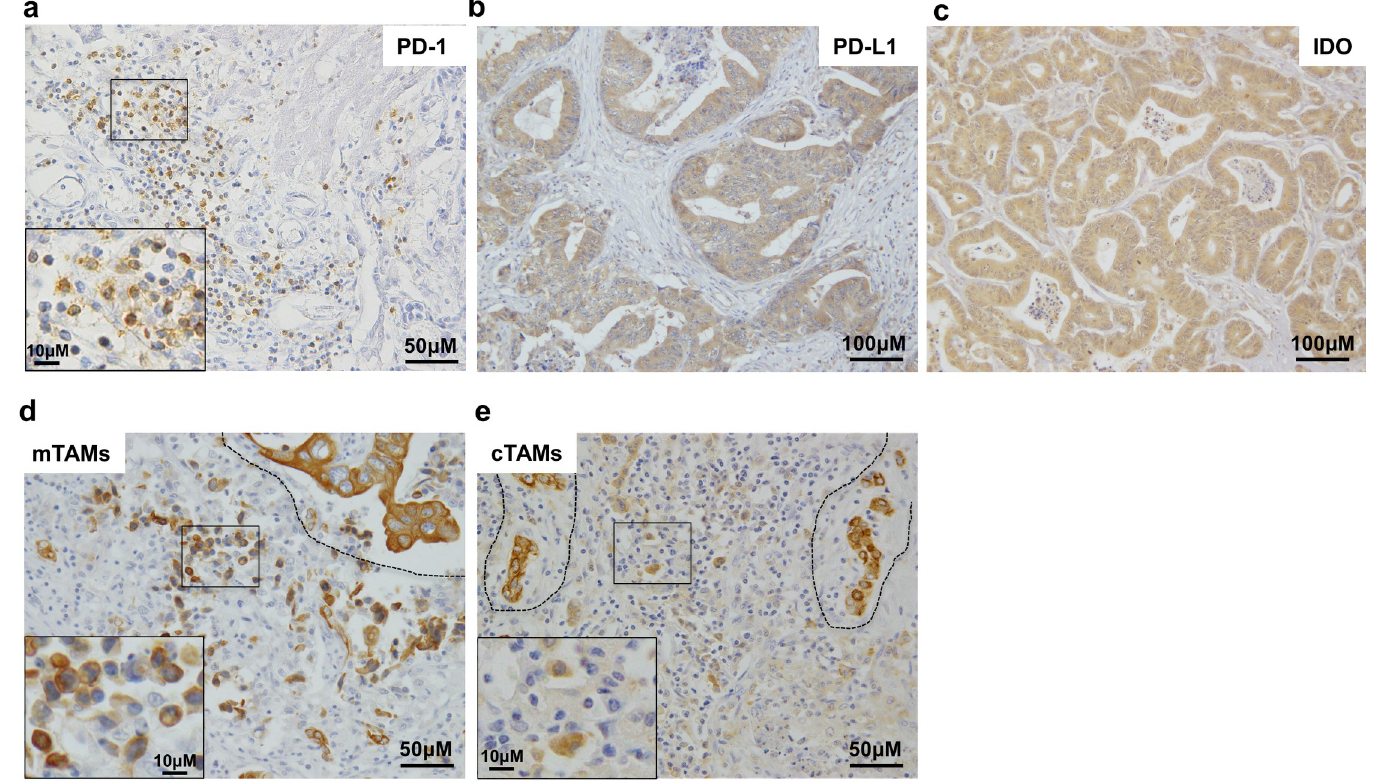
Fig 1. Immunohistochemical analysis of PD-1, PD-L1, IDO, and TAMs expression in colorectal cancer liver metastasis. Representative images are shown. The insets of a, d, and e show high magnification views of the boxed area in each panel. a. PD-1 expression in mononuclear cells in tumor tissue (400 × ).b. PD-L1 expression in tumor cells (200 × ). c. IDO expression in tumor cells (200 × ). d. CD163-positive cells in the marginal areas (mTAMs) of tumor tissues (400 × ). The dashed line delineates the invasive front with the tumor tissue on the top side and the normal tissue on the bottom side. CD-163-positive cells at the tumor margin were defined as mTAMs. e. CD163-positive cells in the central area (cTAMs) of tumor tissue (400 × ). The tumor cells are surrounded by the dashed line. CD163-positive cells at the center of tumor tissue were defined as cTAMs.